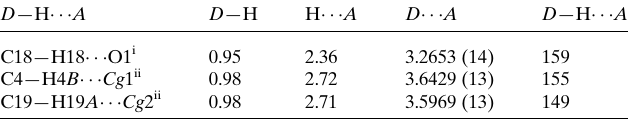
Table 2 Hydrogen-bond geometry (A˚ , (cid:2) ) for (II).